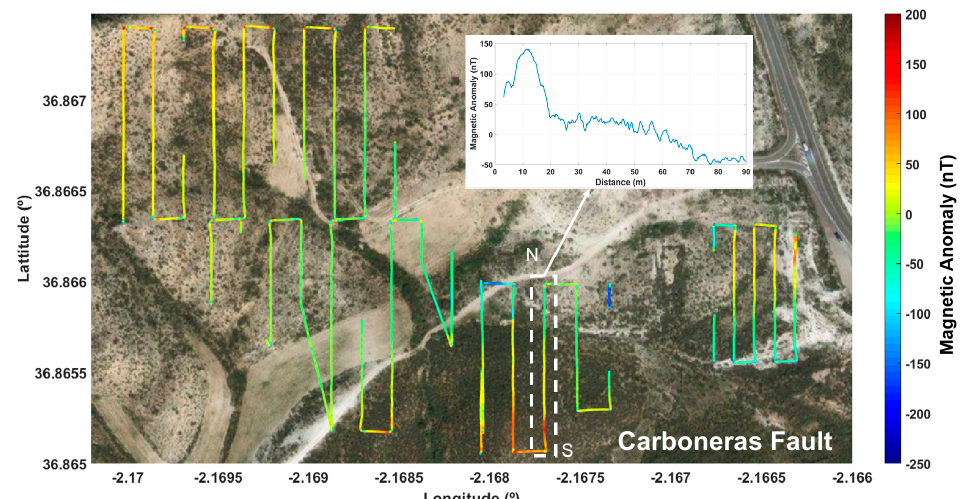
Figure 18. Experimental values of the magnetic field anomaly of the Carboneras Fault registered by the on-drone equipment. Graph concerning the track corresponding to the overflight of the hypothesized lava dome.